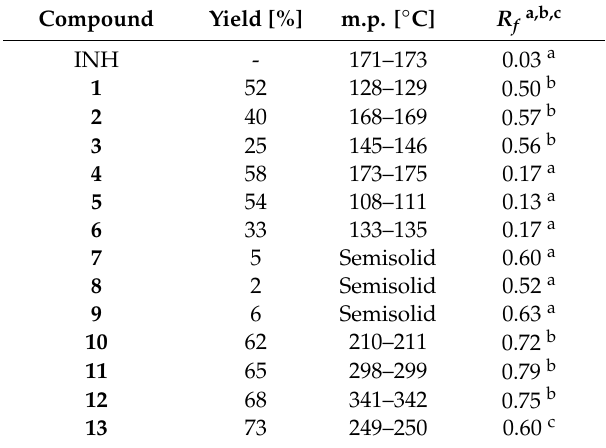
Table 1. Results obtained in the synthesis of the